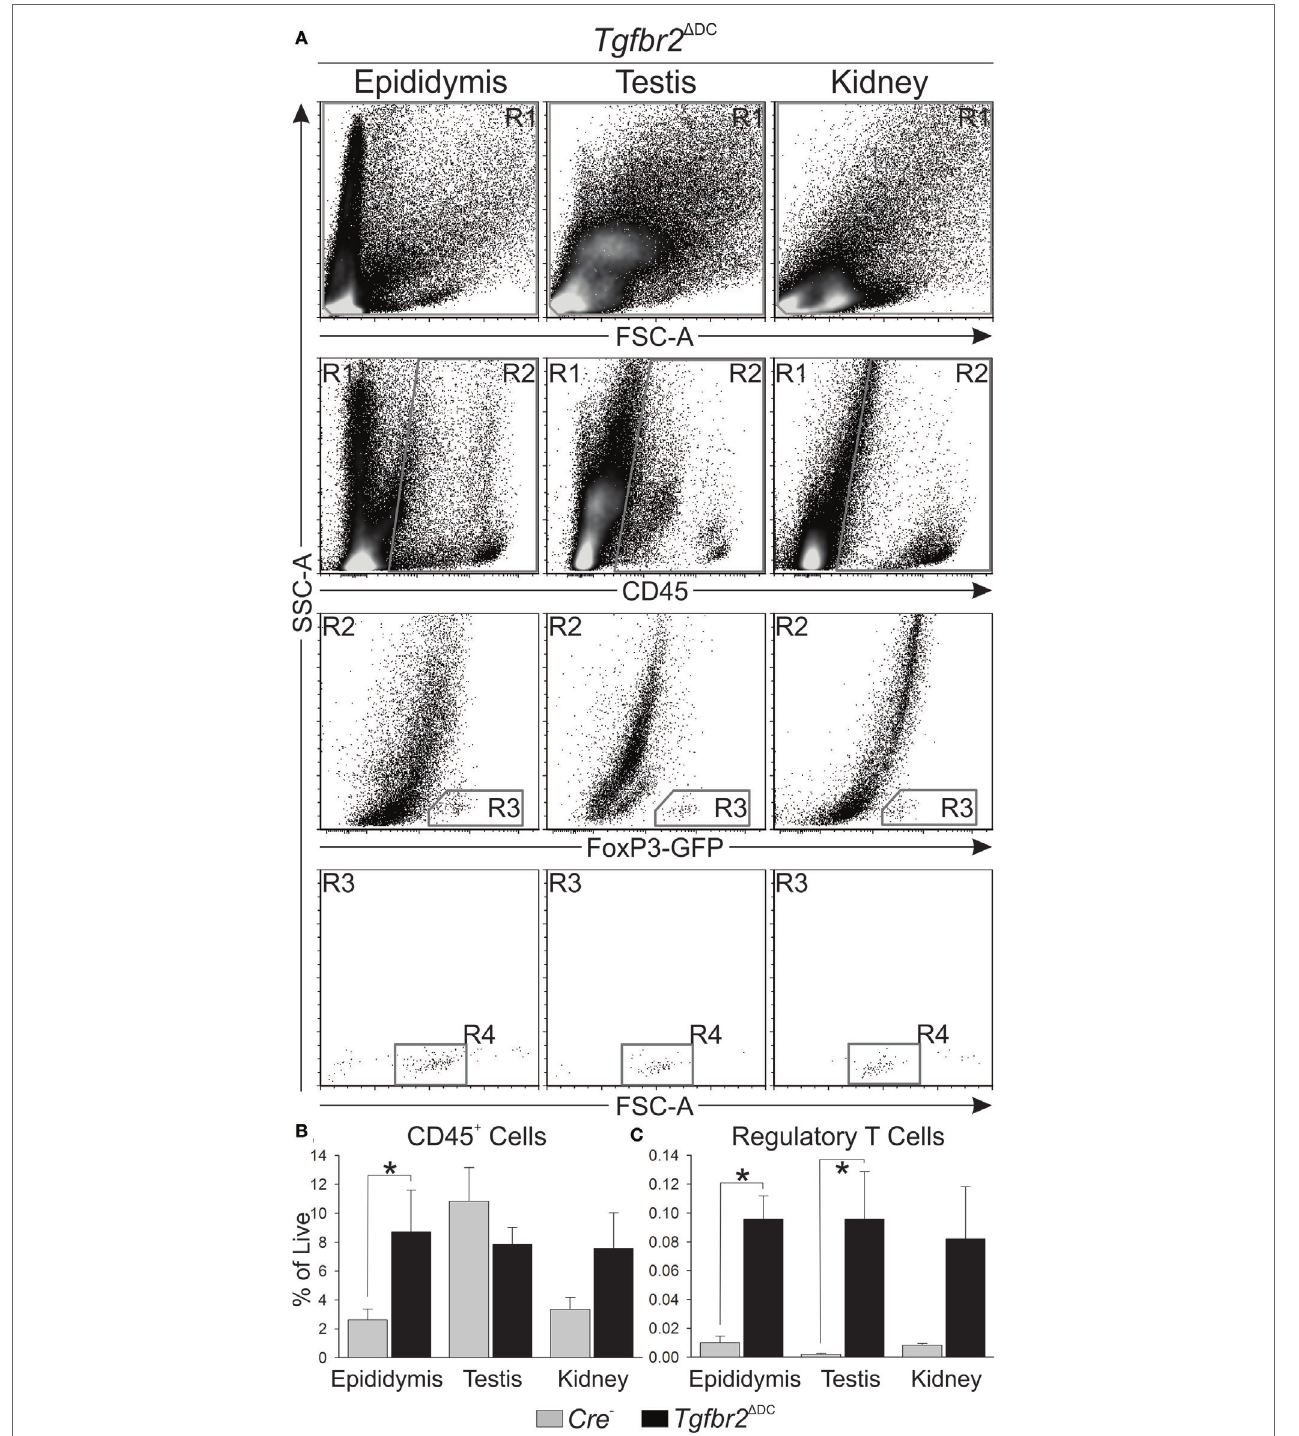
FigUre 3 | Flow cytometric analyses show leukocytosis is greatest in the epididymis when dendritic cells (DCs) lack transforming growth factor beta (TGF β ) signaling. (a) Typical flow cytometry results derived from epididymis, testis, and kidney, and gating strategy employed are shown. All cell suspensions were exposed to a cell viability dye and cells in R1 were separated by a “live gate” (data not shown) prior to definition of CD45 + cell numbers by R2. Regulatory T cells (T regs ) were first gated by R3 and T reg numbers were ultimately defined by R4. (B) Summary of all CD45 + cell quantitation shows the Tgfbr2 Δ DC epididymis exhibits the greatest leukocytosis, while the Tgfbr2 Δ DC testis does not seem affected. Observations included isotype control antibody stains (data not shown), which were employed in data analyses as described in Section “Materials and Methods.” (c) T regs , detected at low numbers in control tissues, were significantly increased in Tgfbr2 Δ DC epididymis and testis. Data are expressed as “% of Live,” as in panel (B) . N = 5 (pairs of Cre − and Tgfbr2 Δ DC littermate males, age 9–10 weeks); p ≤ 0.05. A total of 100,000 events per sample were